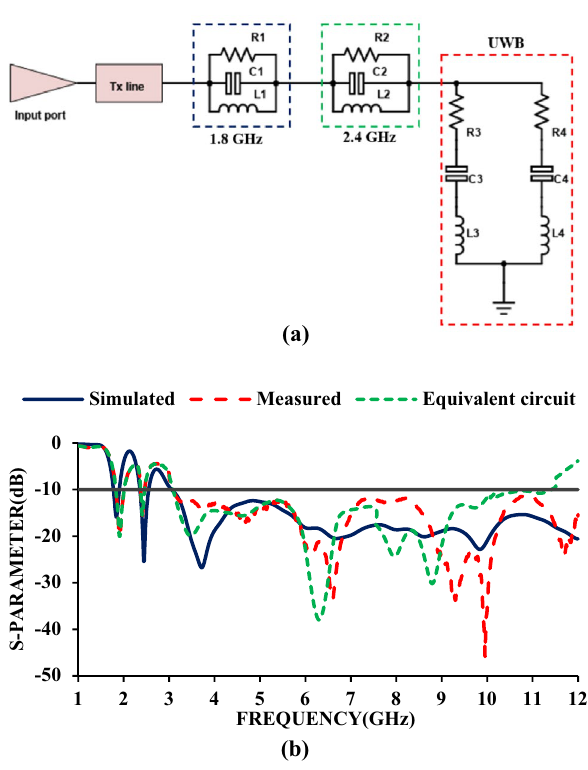
Figure 6. ( a ) Equivalent circuit and ( b ) S-parameters of the equivalent circuit.